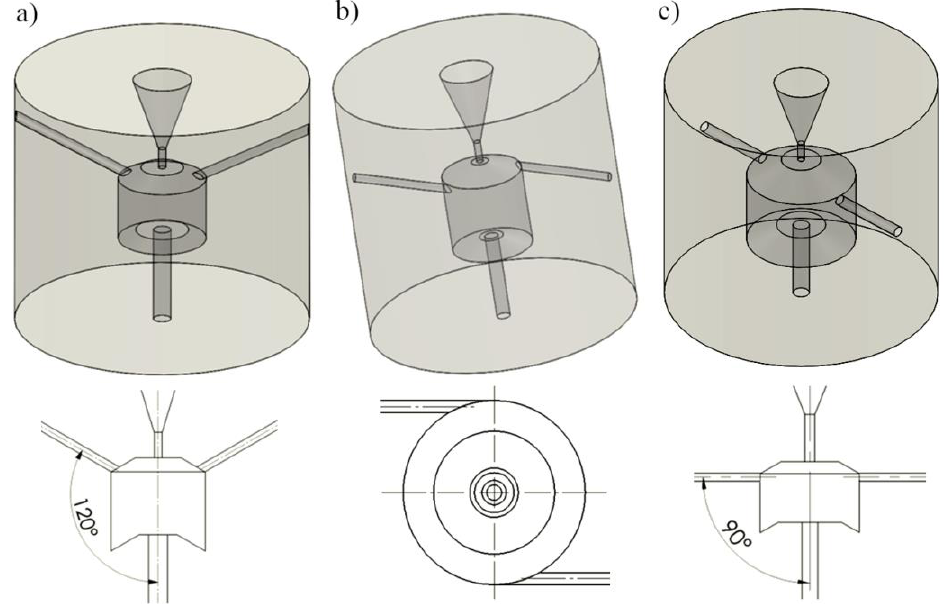
Figure 2. Differentiation of the geometry of the self-excited pulse head with different locations of the side holes: ( a ) inclined at an angle of 120 ◦ to the axis of the head; ( b ) tangential to the swirl chamber; ( c ) perpendicular to the axis of the head.